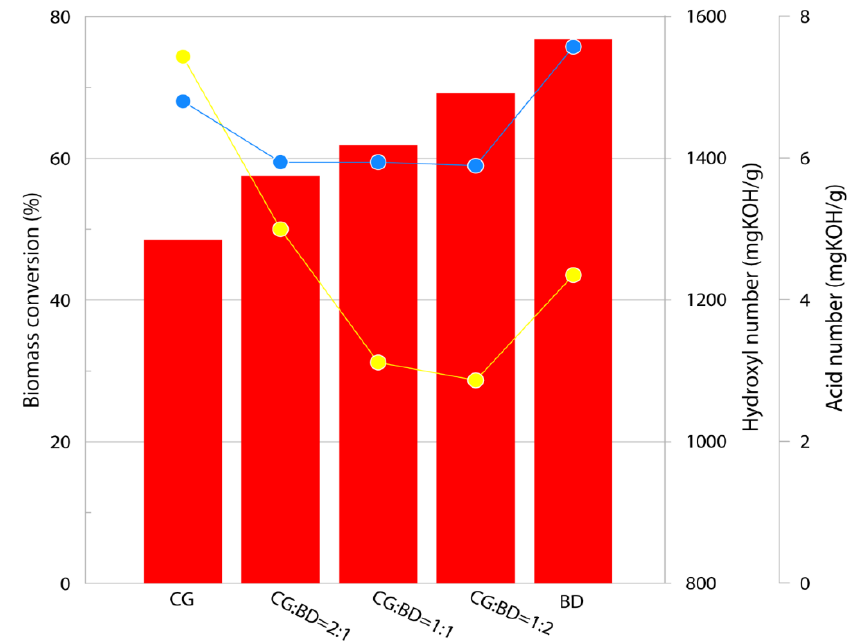
Figure 2. Effect of solvent blending ratio on biomass conversion and biopolyol acid number (blue line) and hydroxyl number (yellow line). Reaction condition: temperature, 120 °C; biomass load- line) and hydroxyl number (yellow line). Reaction condition: temperature, 120 ◦ C; biomass loading, ing, 10%; catalyst loading, 1%; reaction time, 10 min. 10%; catalyst loading, 1%; reaction time, 10